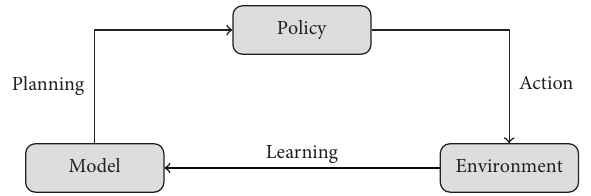
Figure 13: Model-based reinforcement learning